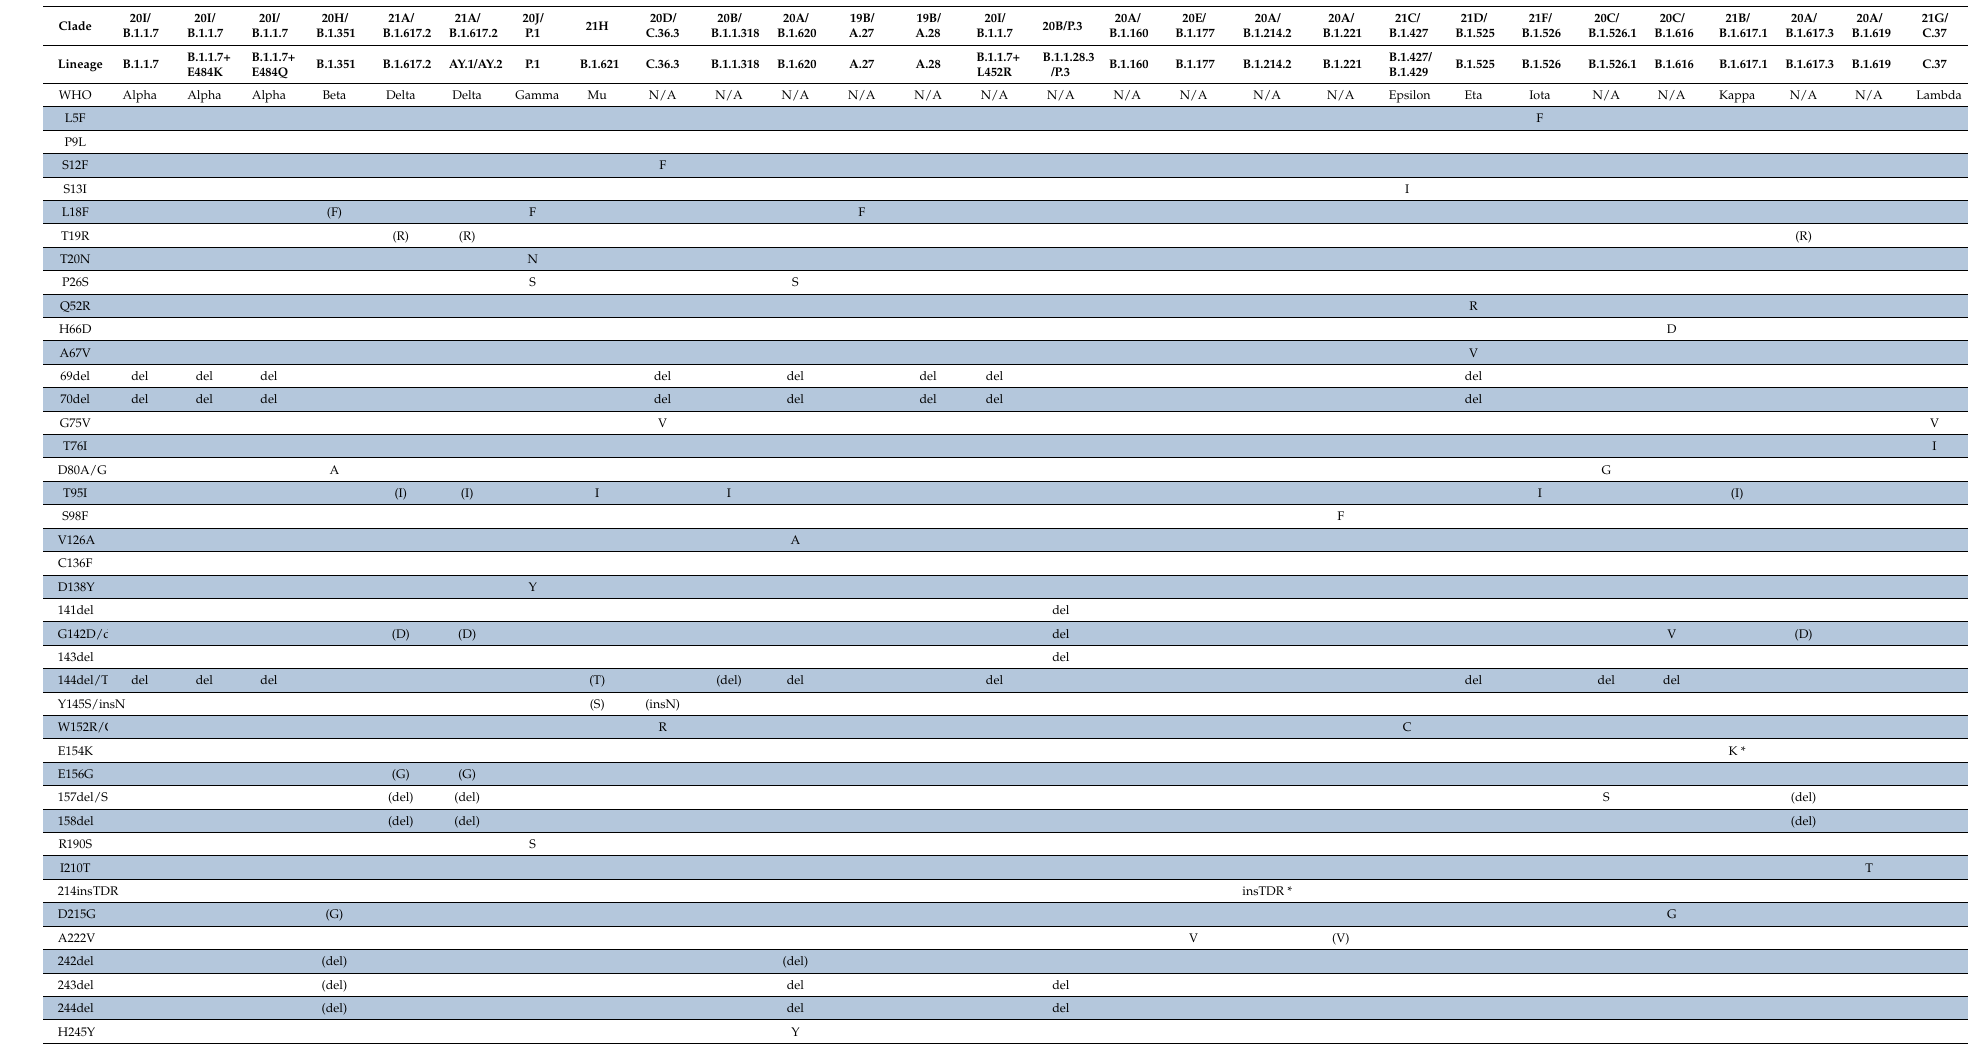
Table 1. Key mutations used for clade/lineage